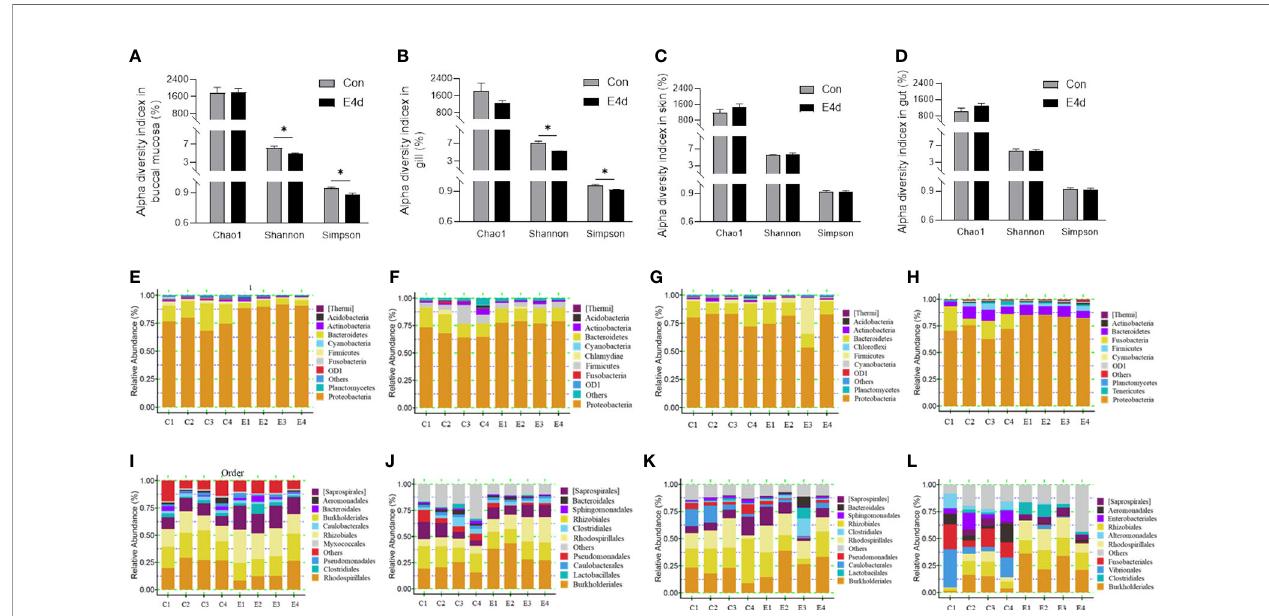
FIGURE 3 | Microbiota community changes in mucosal tissues of common carp in response to SVCV infection. (A – D) Alpha diversity of bacterial community in common carp BM (A) , gills (B) , skin (C) , and gut (D) from control and infected groups ( n = 4 fi sh per group). Richness and diversity of the bacterial community was measured using Chao1 mean and Shannon index, respectively. Error bars represent standard error of mean (SEM). Kruskal-Wallis test was conducted between groups with signi fi cance level. Control vs. Infection: * P < 0.05. (E – H) Bar chart of the relative abundance of phylum present at BM (E) , gills (F) , skin (G) , and gut (H) from control fi sh and experimental fi sh infected with SVCV after 4 days. (I – L) Bar chart of the relative abundance of order present at BM (I) , gills (J) , skin (K) , and gut (L) from control fi sh and experimental fi sh infected with SVCV after 4 days. BM, buccal mucosa; E4d, 4 days after SVCV